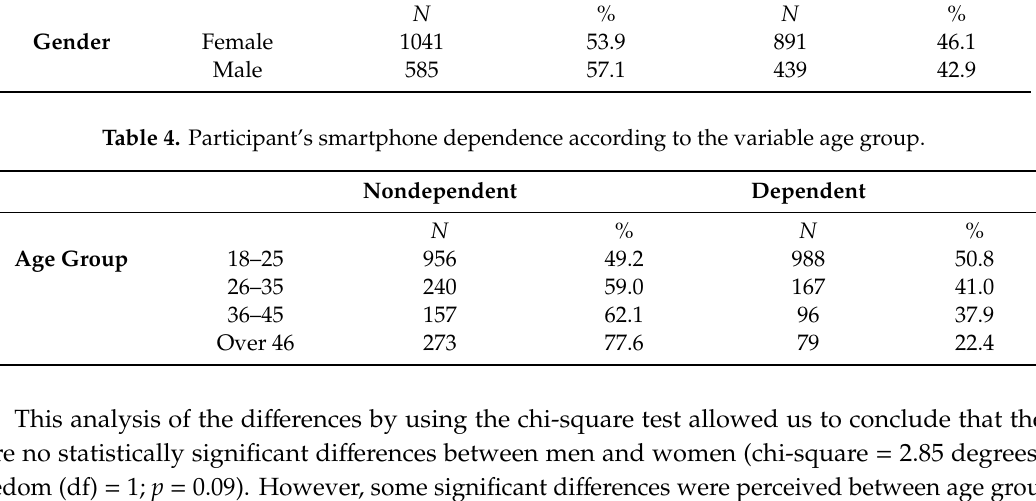
Table 3. Participant’s smartphone dependence according to the variable gender. Nondependent